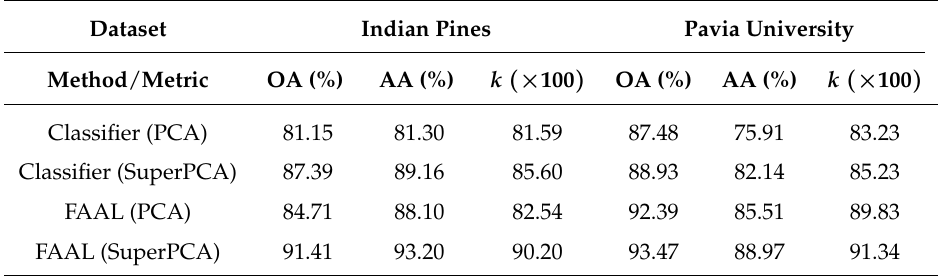
Table 4. Comparison of the naive classifier and feature-oriented adversarial active learning (FAAL) with two different dimensionality reduction